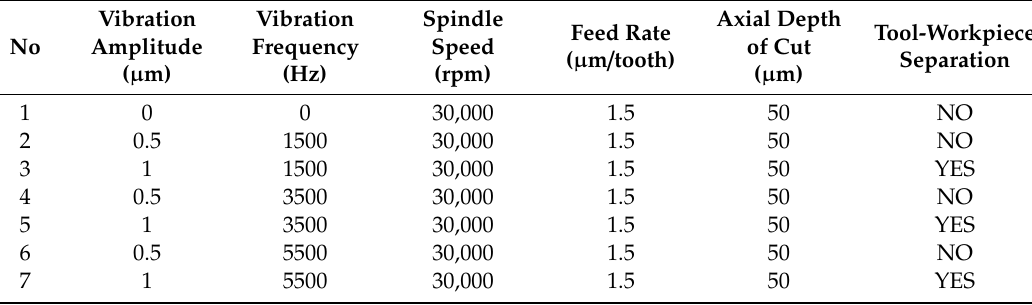
Figure 4. Finite element (FE) model of vibration-assisted machining. Table 1. Machining and vibration parameters used in the experiments.